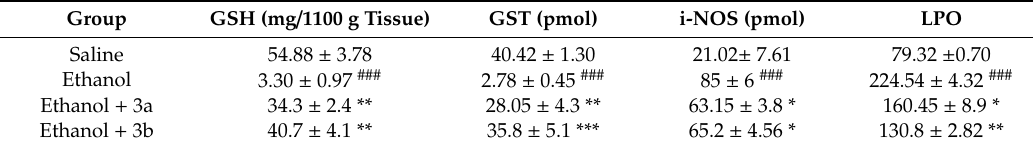
Table 2. E ff ect of 3a and 3b on oxidative